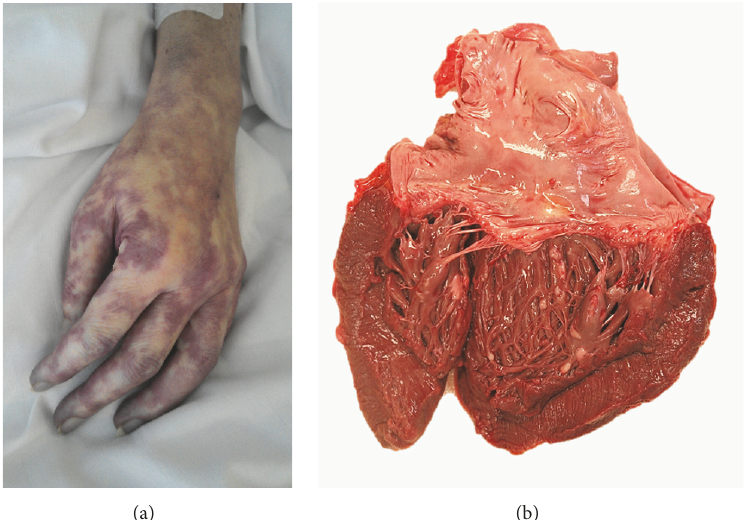
Figure 1: (a) Skin with regional vasospasm; (b) opened heart, showing multiple small white metastases of a midgut NET.